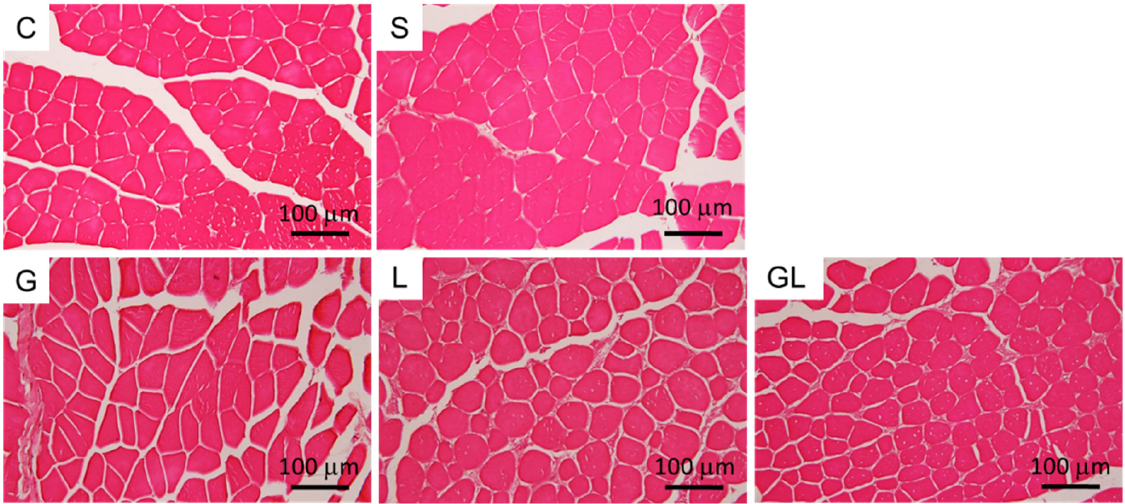
Figure 6. H&E staining of the gastrocnemius (GA) muscle. Representative histological images on day 4 postoperatively (200× magnification) are provided. The groups are described in the legend to Table 1.